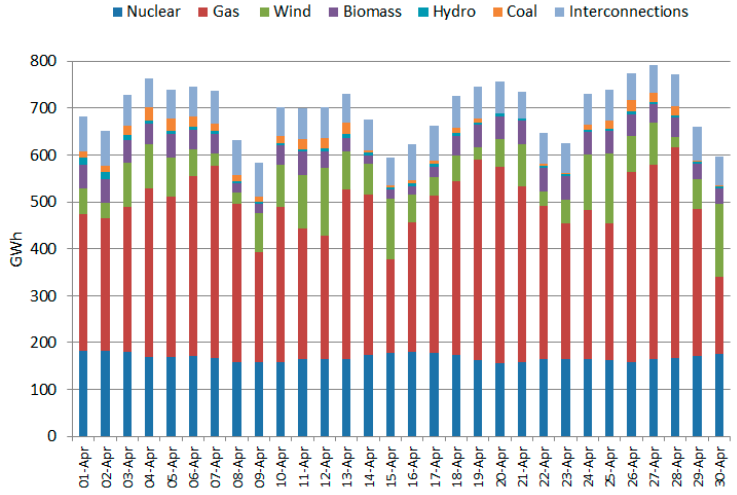
Figure 19. Daily energy generation in the UK by source, April 2017. Data retrieved from [61].